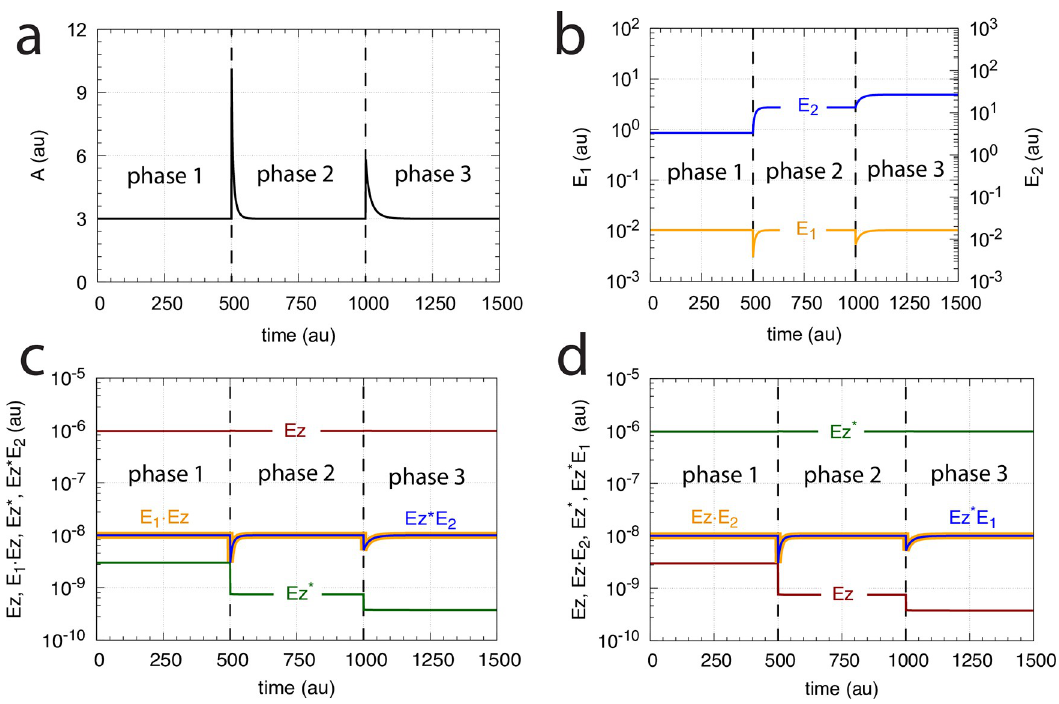
Fig 62. The m7 ping-pong mechanisms (Fig 59) show identical homeostatic responses for step-wise changes in k 1 . Phase 1: k 1 =100.0, phase 2: k 1 =400.0, phase 3: k 1 =800.0. (a) A as a function of the step-wise changes in k 1 for both controllers. (b) Concentration profiles of E 1 and E 2 for both controllers. (c) Concentration profiles of the enzyme species for the mechanism in Fig 59a. (d) Concentration profiles of the enzyme species for the mechanism in Fig 59b. Other rate constants: k 2 = k 3 =0, k 4 =10.0, k 5 =31.0, k 6 =1.0, k 7 =1 × 10 8 , k 9 = k 11 = k 13 =1 × 10 8 , k 12 = k 14 =1 × 10 3 , k 17 =0.1. Initial concentrations for the controller of Fig 59a: A 0 =3.0, =3 × 10 − 9 , (Ez � � E 2 ) 0 =1.0 × 10 − 8 . Initial concentrations for the E 1,0 =1.0 × 10 − 2 , E 2,0 =3.33, Ez 0 =9.77 × 10 − 7 , (E 1 � Ez) 0 =1.0 × 10 − 8 , Ez � 0 controller of Fig 59b: